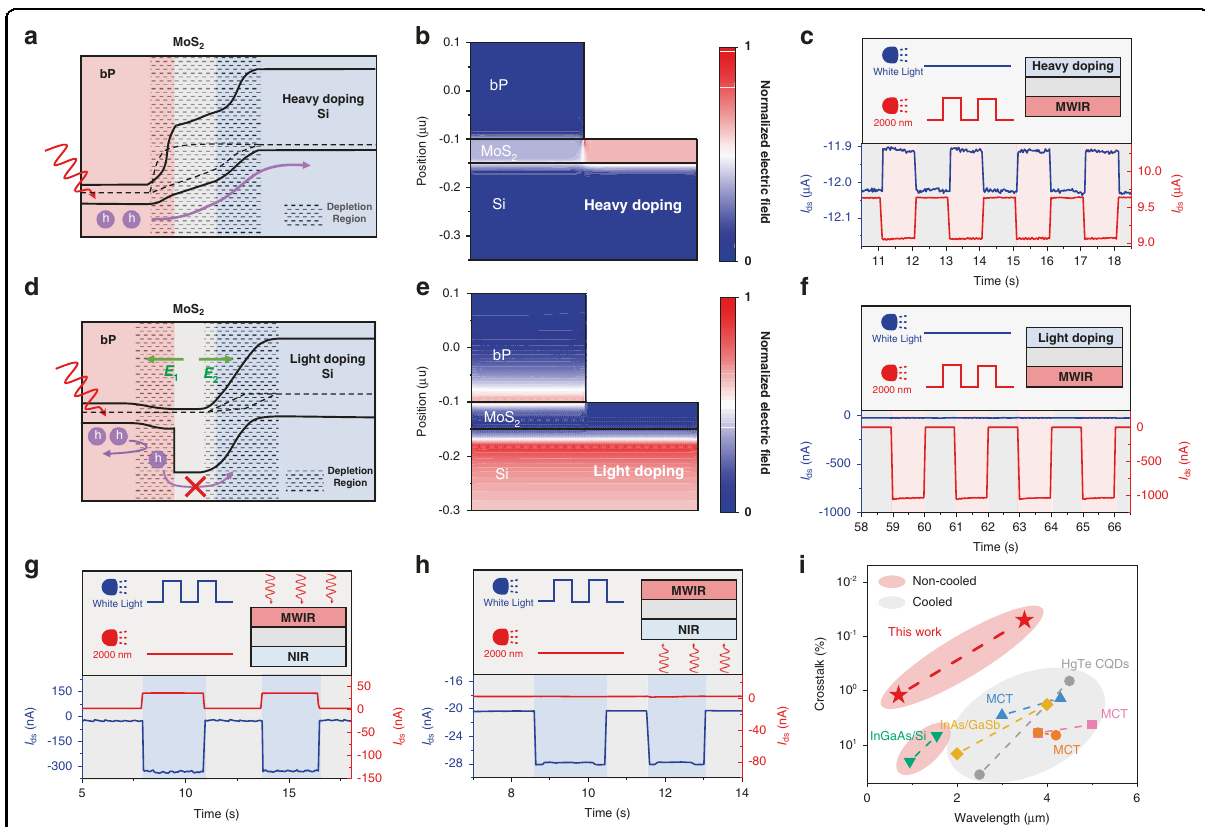
Fig. 3 Ultralow crosstalk in bP/MoS 2 /Si two-color IR photodetector. a Band diagram and depletion region distribution of heavily doped Si two- color devices in working mode. b Electric fi eld distribution of heavily doped Si two-color devices in working mode. c Photocurrent of heavily doped Si two-color photodetector under a modulated illumination source ( λ = 2 μ m). Red and blue line are MWIR and NIR photocurrents, respectively. d Band diagram and depletion region distribution of light doped Si two-color devices in working mode. e Electric fi eld distribution of light doped Si two-color devices in working mode. f Photocurrent of light doped Si two-color photodetector under a modulated illumination source ( λ = 2 μ m). g Photocurrent of light doped Si two-color photodetector under a modulated illumination source (White light) in front radiation mode. h Photocurrent of light doped Si two-color photodetector under a modulated illumination source (White light) in back radiation mode. i Crosstalk performance of bP/MoS 2 /Si devices and various reported two-color